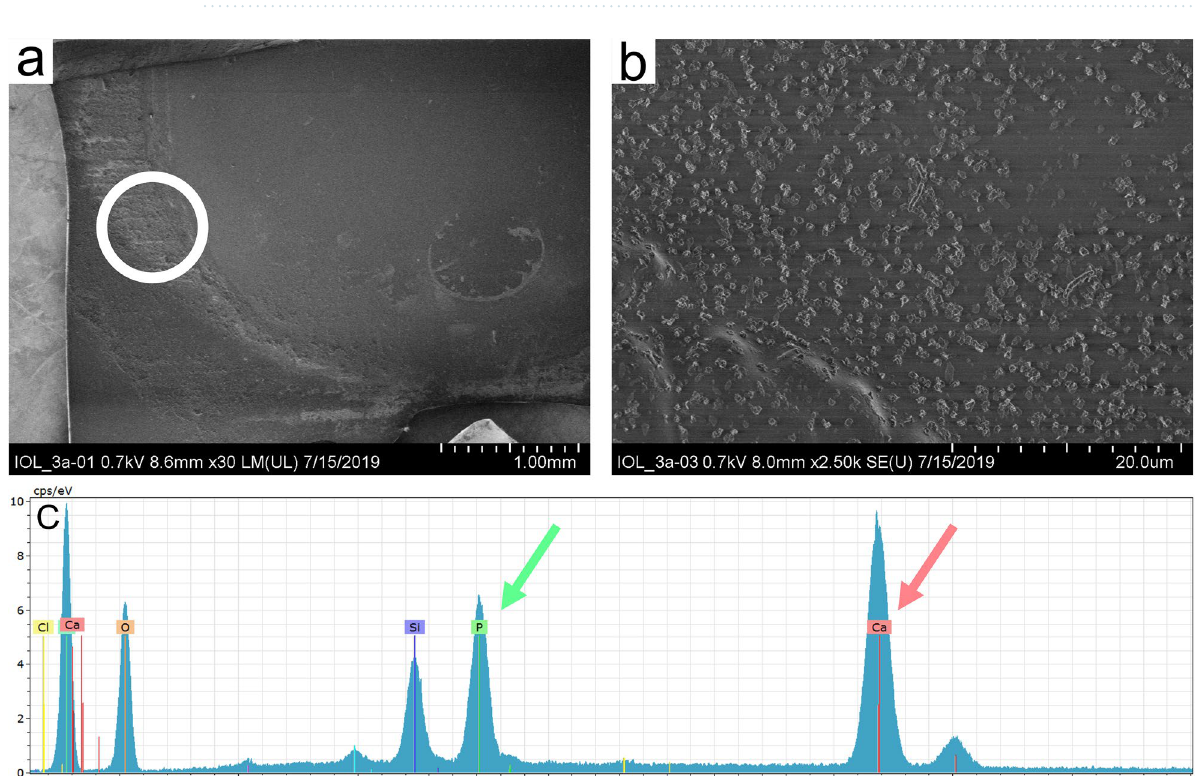
Figure 4. Analysis of surface deposits of IOL 3a. Scanning electron microscopy ( a , b ) shows deposits formed on the IOL’s surface. Energy dispersive X-ray spectroscopy ( c ) investigation shows high peaks of 6,5 cps/eV at 2 keV characteristic for phosphorus (P) and 9,5 cps/eV at 3,7 keV characteristic for calcium (Ca). These findings confirm the deposits to be calcium phosphates. Since the sample was placed on a silicon waver for analysis, a silicon peak (Si) can be found in the EDX result. Carbon (C) and oxygen (O) peaks originate from the IOL